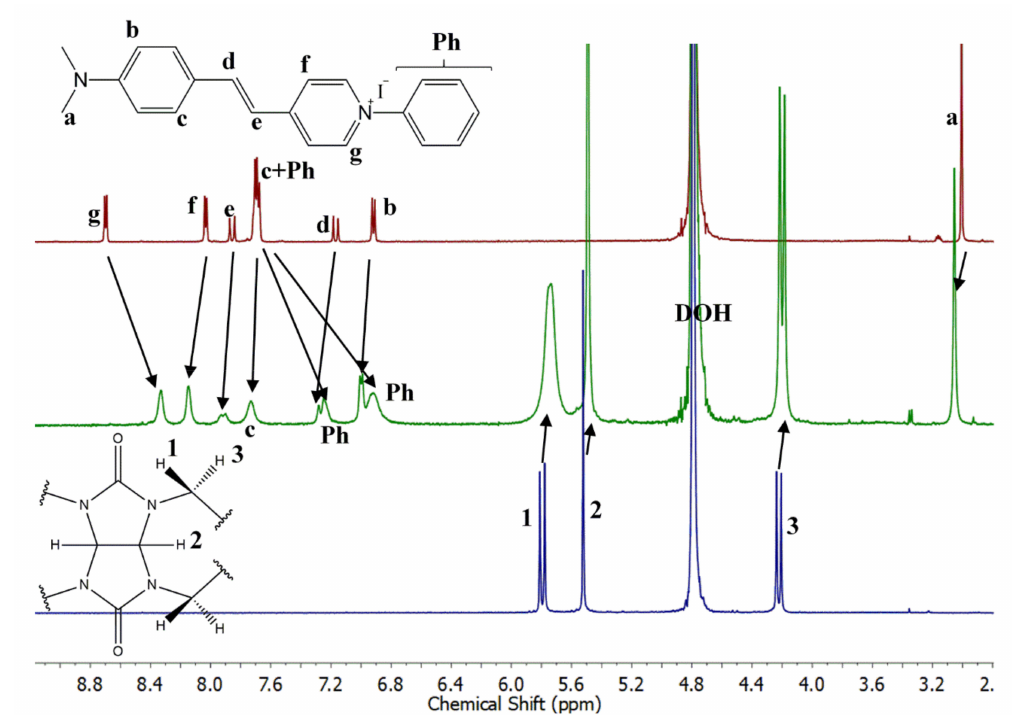
Figure 8. 1H-NMR spectra (500 MHz, D 2 O) of ( top ) PhSt, ( middle ) PhSt-CB7 1:1 mixture, ( bottom ) CB7. [PhSt] = [CB7] = 5 × 10 − 4 M.